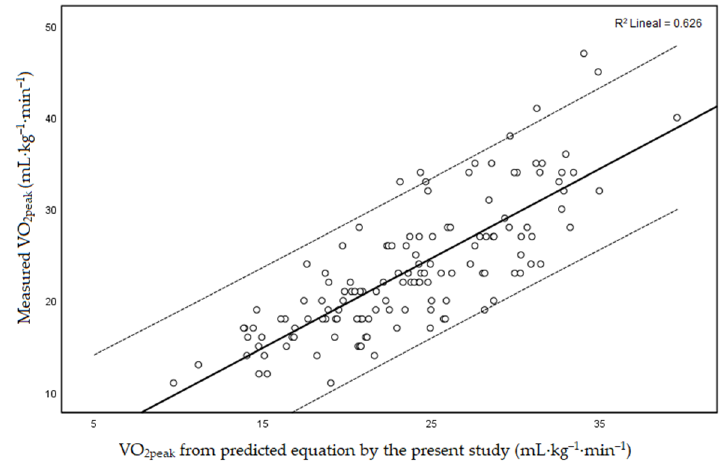
Figure 1. Relationship between measured VO 2peak and VO 2peak values from the predicted equation generated in the present study. The central line represents the linear regression line, and the flanking lines represent the 95% individual prediction intervals. CPET, cardiopulmonary exercise test; VO 2peak , peak oxygen uptake.